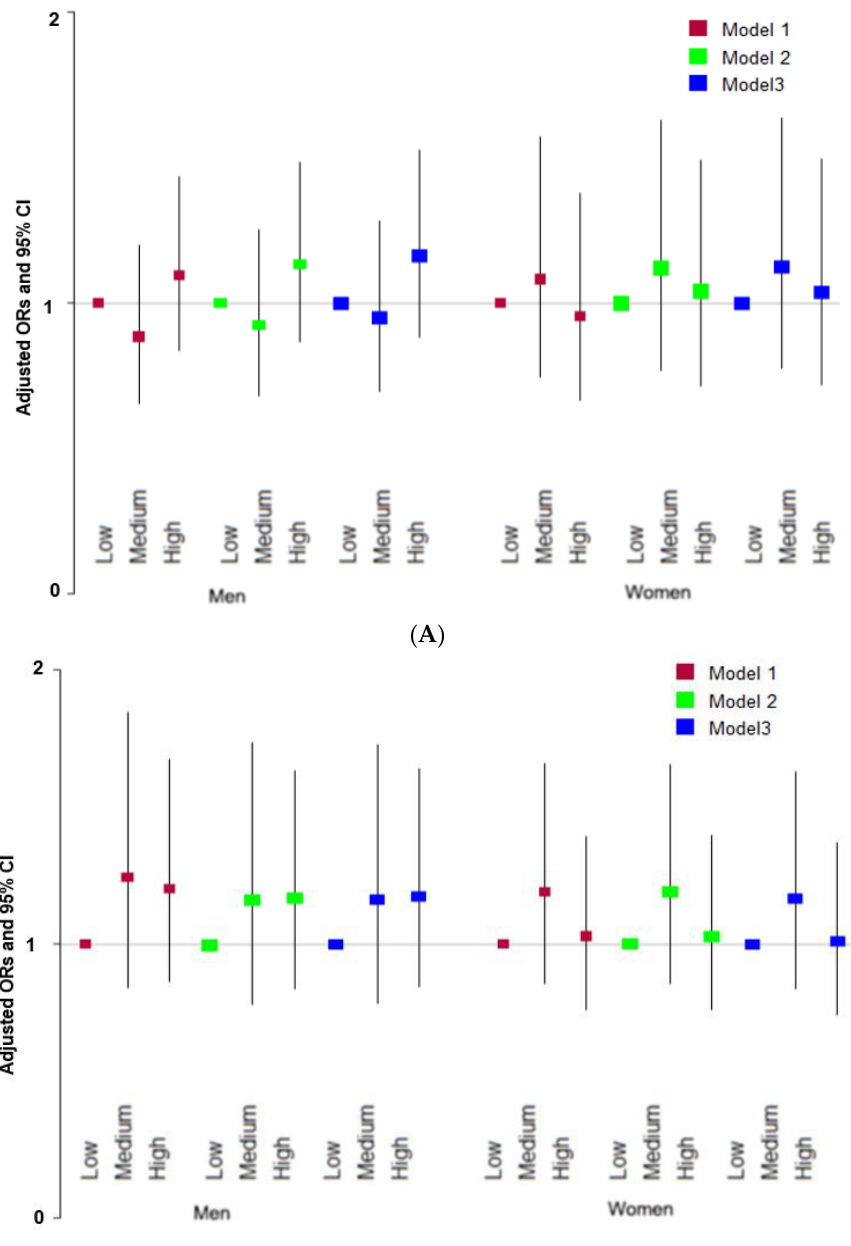
Figure 2. Association of the modified Korean healthy eating index (MKHEI) scores of Korean- and Western-style diets with type 2 diabetes risk. ( A ) Adjusted ORs of MKHEI scores of Korean-style diets; ( B ) Adjusted ORs of MKHEI scores of Western-style diets; ORs and 95% CI are represented with colored boxes and lines, respectively. Models were generated with different covariates, including age, gender, regions, and area of residence for model 1; covariates for model 1 plus energy intake, education, income, marital status, and obesity for model 2; and covariates for model 2 plus smoking, alcohol consumption, and regular exercise for model 3.